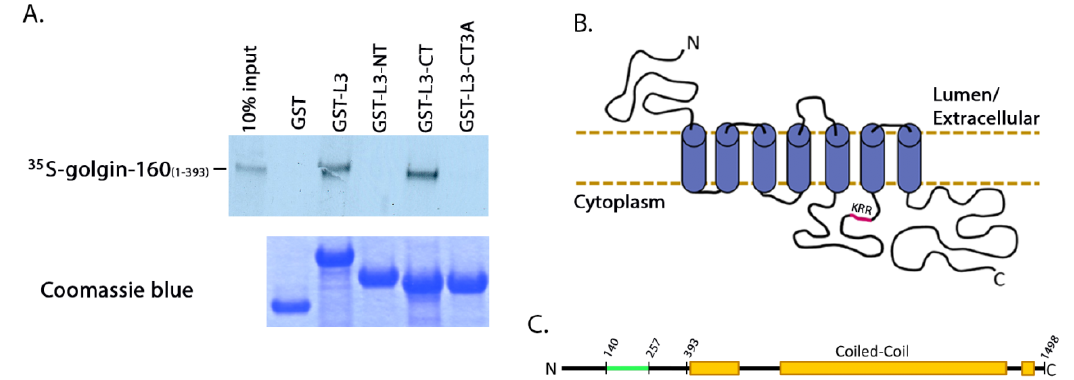
Figure 2. Three basic residues in the intracellular loop 3 of β 1AR are required for binding to golgin-160. ( A ) Purified GST, GST- β 1AR L3, GST- β 1AR L3-NT, GST- β 1AR L3-CT, or GST- β 1AR L3-CT/3A were pre-bound to glutathione-Sepharose beads and incubated with [ 35 S]-labeled golgin-160 . After washing the beads, bound golgin-160 was (1–393) (1–393) detected by phosphorimaging after SDS-PAGE. The input lane represents 10% of the starting material. The GST fusion proteins were visualized for equal loading with Coomassie blue staining; ( B ) The KRR residues are located in the third intracellular loop of β 1AR, shown in magenta in this flattened schematic of the receptor; ( C ) The β 1AR binding region between residues 140 and 257 of golgin-160 is shown in green [15]. The coiled-coils characteristic of golgins are shown in orange.